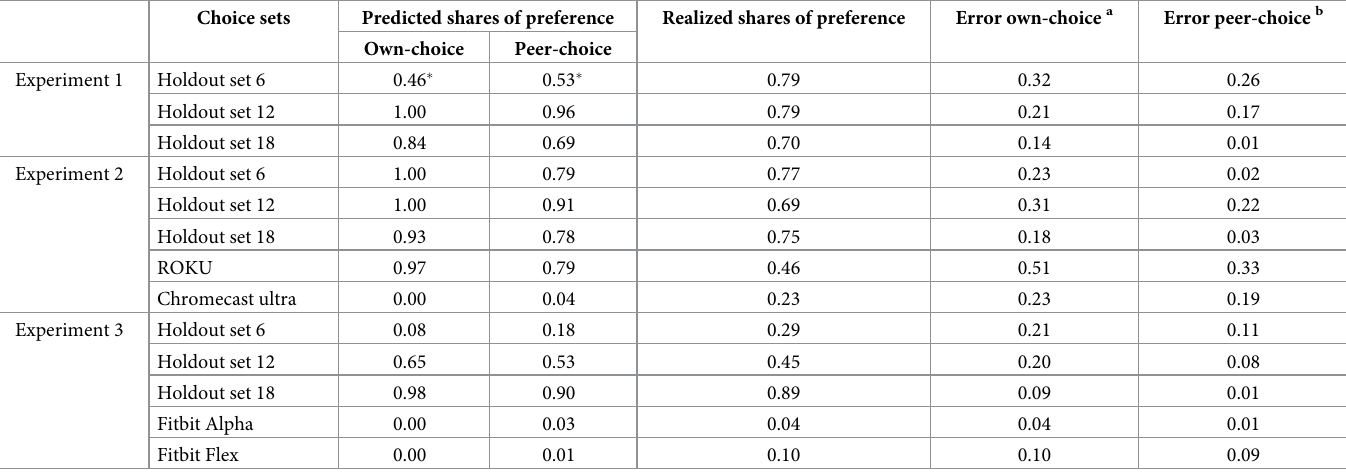
Table 1. Prediction errors: The own-choice model and the peer-choice model (Experiments 1, 2, and 3). Choice